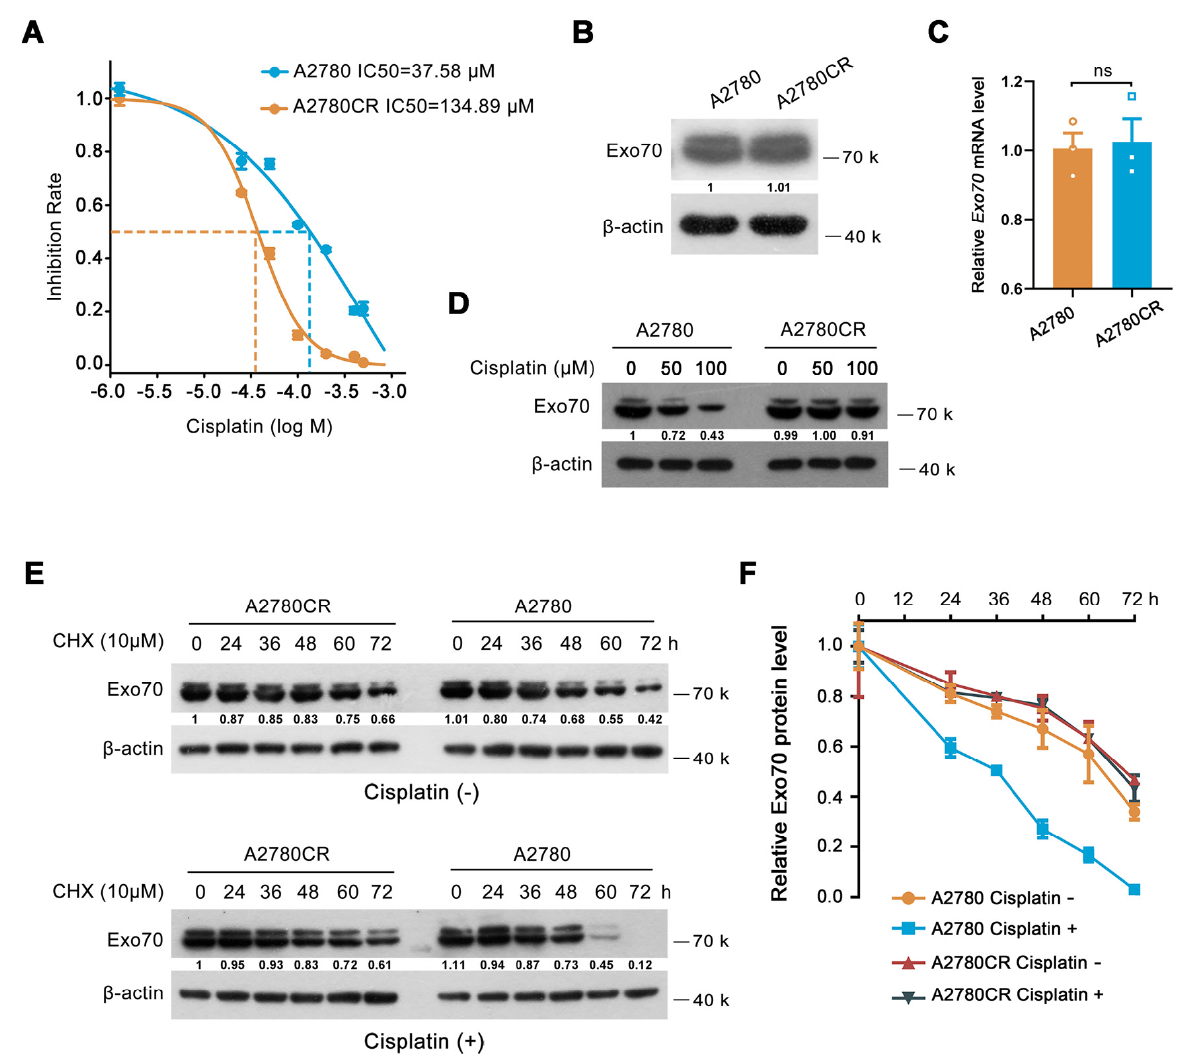
Figure 4. Exo70 is stabilized in cisplatin − resistant EOC cells. ( A ) IC50s of cisplatin in A2780 and A2780CR cells were measured by CCK8 assay. ( B ) Western blotting showed Exo70 expressions in A2780 and A2780CR cells. ( C ) RT − PCR results showed the Exo70 mRNA expression levels in A2780 and A2780CR cells. ns: not significant. ( D ) Western blotting detected Exo70 expression in A2780 and A2780CR cells with the treatment of different doses of cisplatin for 3 h. ( E ) Western blotting detected the half − lives of Exo70 in A2780 and A2780CR cells. Cells were treated with 10 µ M CHX with or without 12.5 µ M cisplatin for indicated times. ( F ) Density analysis of Exo70 expressing level with CHX treatment together with or without cisplatin in A2780 or A2780CR cells. Data were presented as mean ± SEM, n =